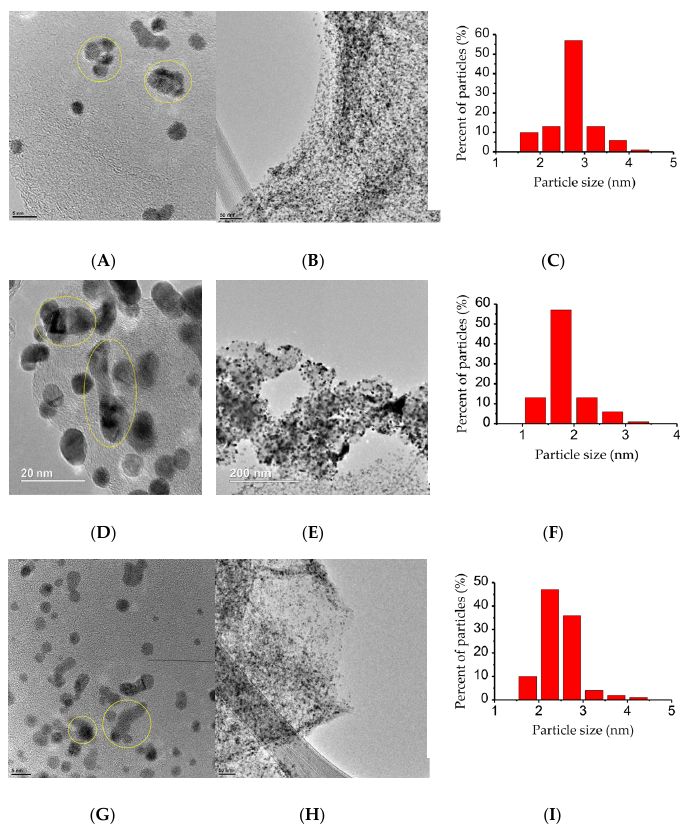
Figure 1. TEM images of Pt 20 /rGO ( A , B ), Pt 20 /rGO-O ( D , E ) and Pt 20 /rGO-Am ( G , H ), the corresponding Pt nanoparticles size distribution ( C , F , I ).